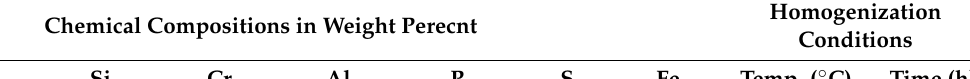
Table 1. Chemical compositions and heat treatment conditions of the three wire rod steels used in this experiment.